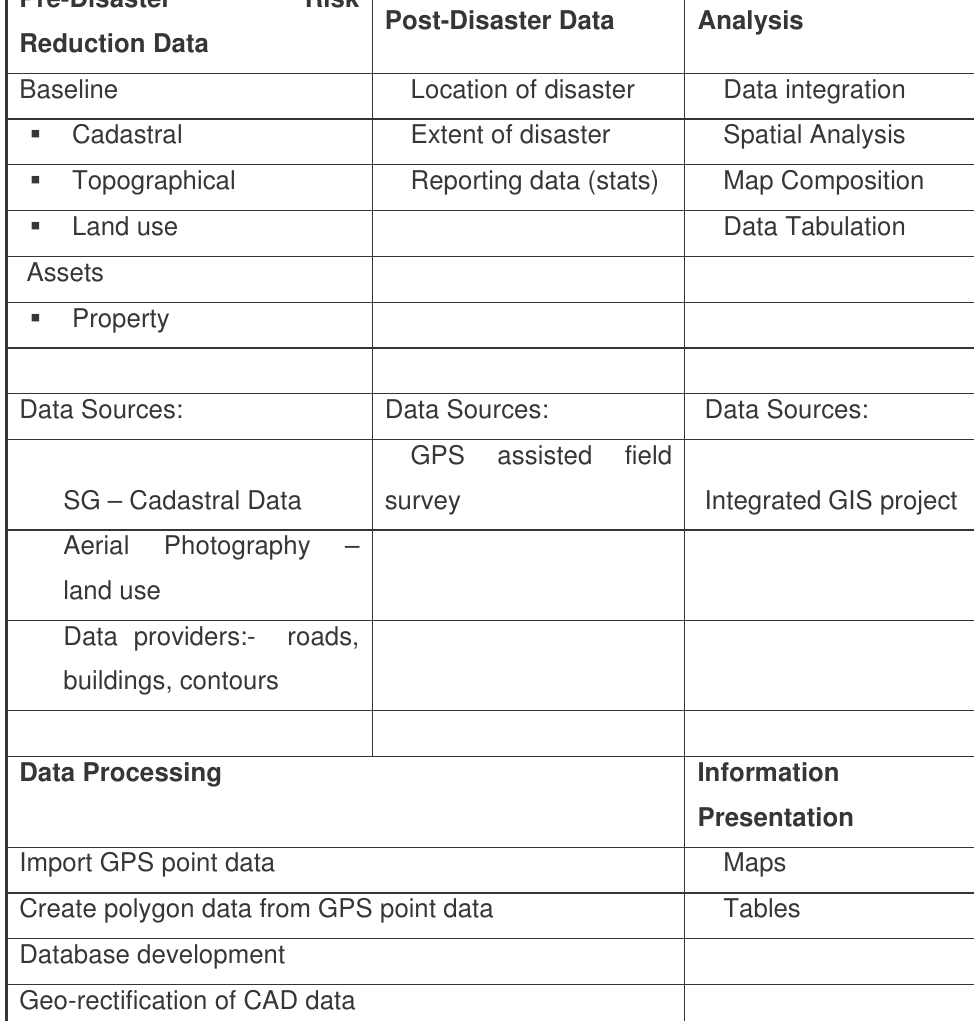
Table 3: Typical data needs and processing activities for disaster